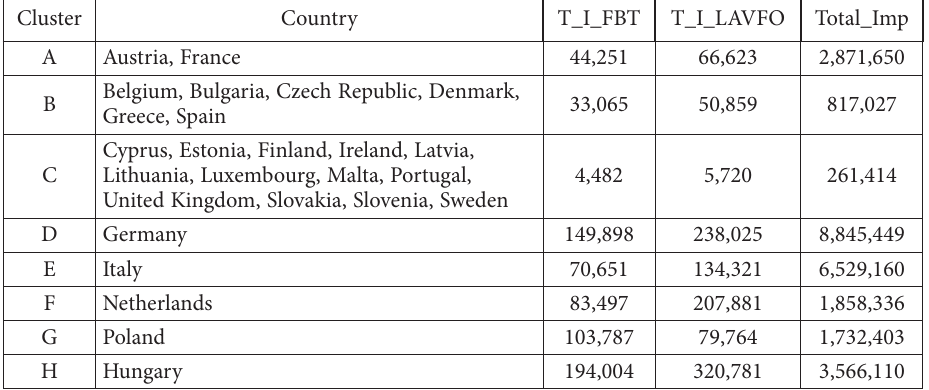
Table 3. EU states grouping according to the average volume at group level of Romania’s imports (FOB) in 2007 (thousands euro) (source: authors based on NIS, 2018)